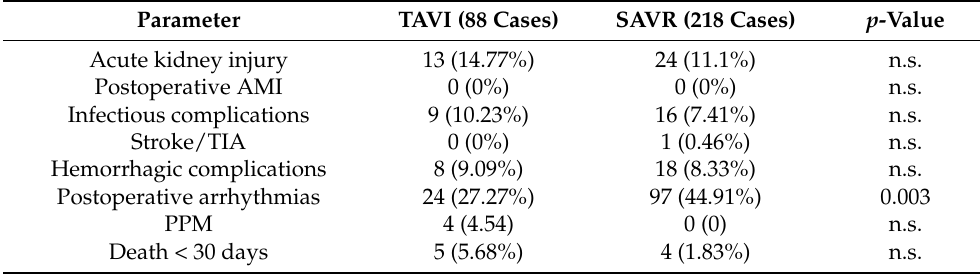
Table 2. Postoperative morbidity and mortality depending on the type of